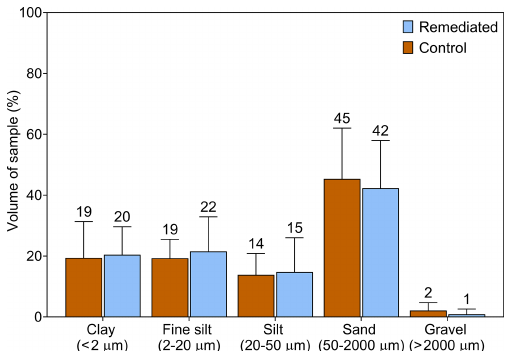
Figure 6. Average PSDs, by size class, of soil collected from the control (brown; n = 4) and remediated (blue; n = 14) gullies prior to remedial works. Error bars represent the standard deviation of each class.